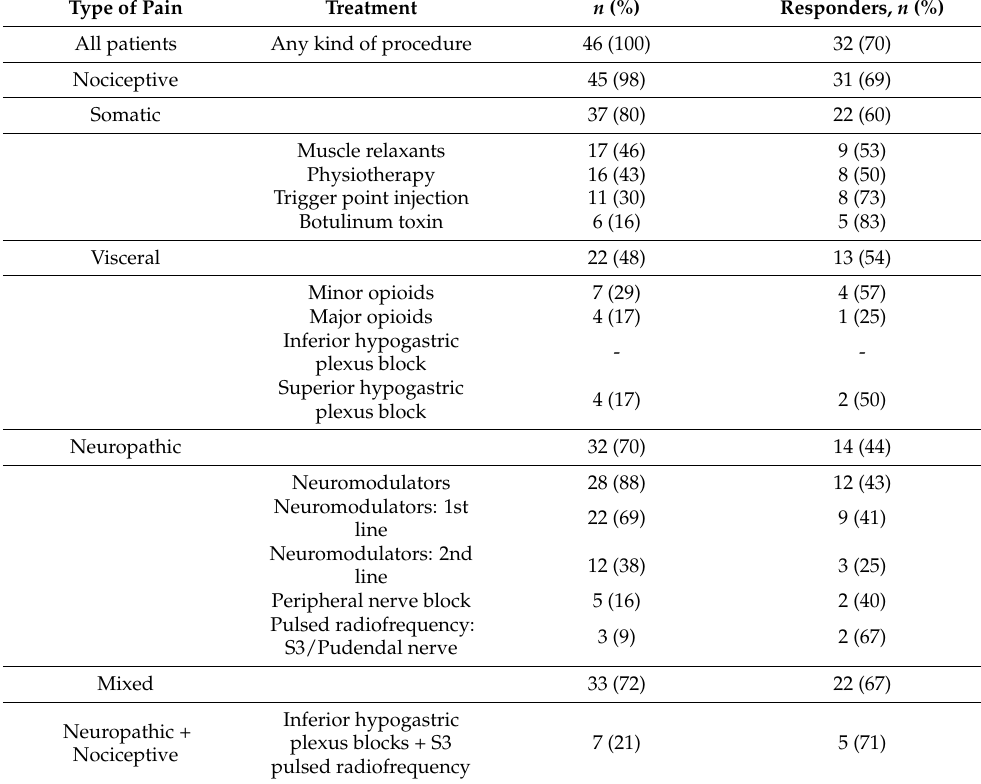
Table 3. Descriptive analyses with examination findings of endometriosis patients unresponsive to conventional